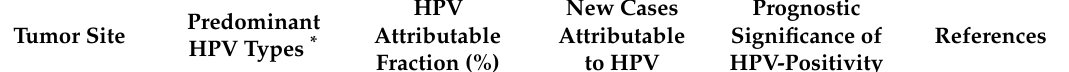
Table 1. Worldwide burden of cancer attributable to Human Papilloma Virus (HPV) by site.